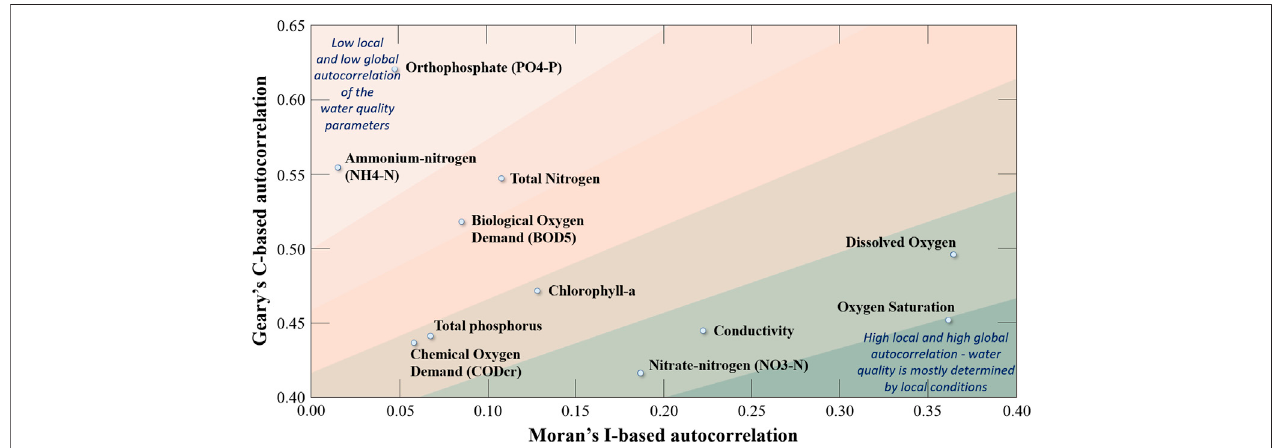
FIGURE 8 | The integrated interpretation of the Moran ’ s I and Geary ’ s C spatial autocorrelation measures of the water quality parameters of Hungarian surface water bodies (spatial autocorrelation decreases from darker green to light brown in the bivariate representation, taking into account the different characteristics of the proposed new combined Geary ’ s and Moran ’ s measures).